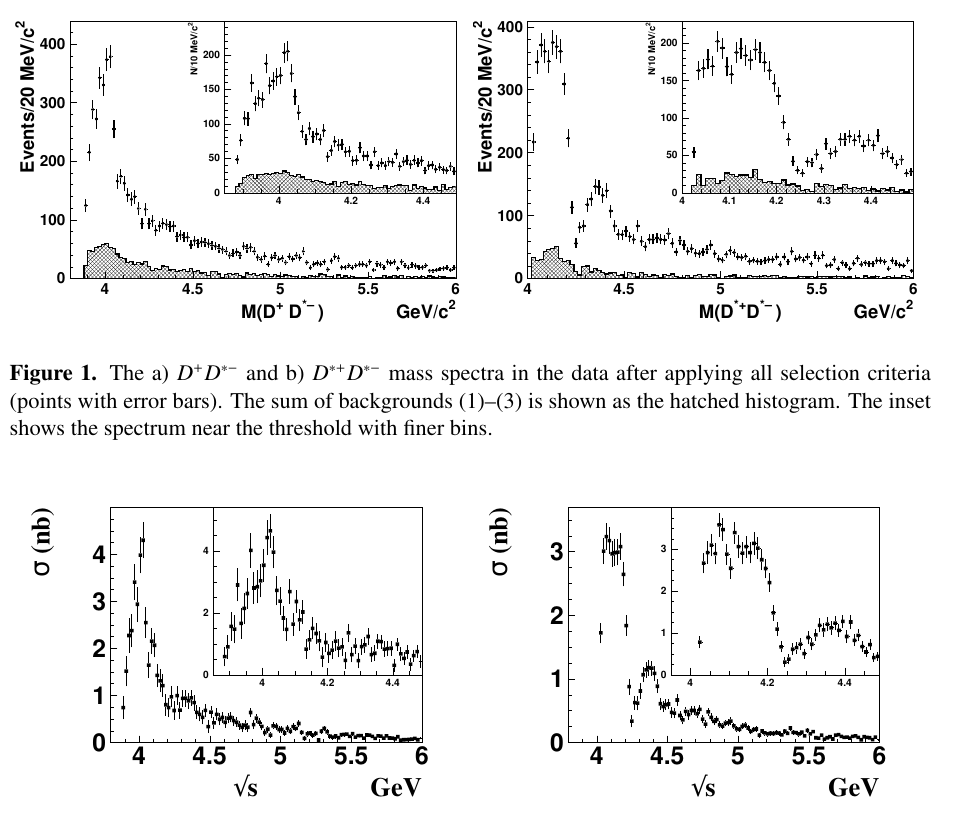
D + D ∗− (left) and e + e − D ∗ + D ∗− → →